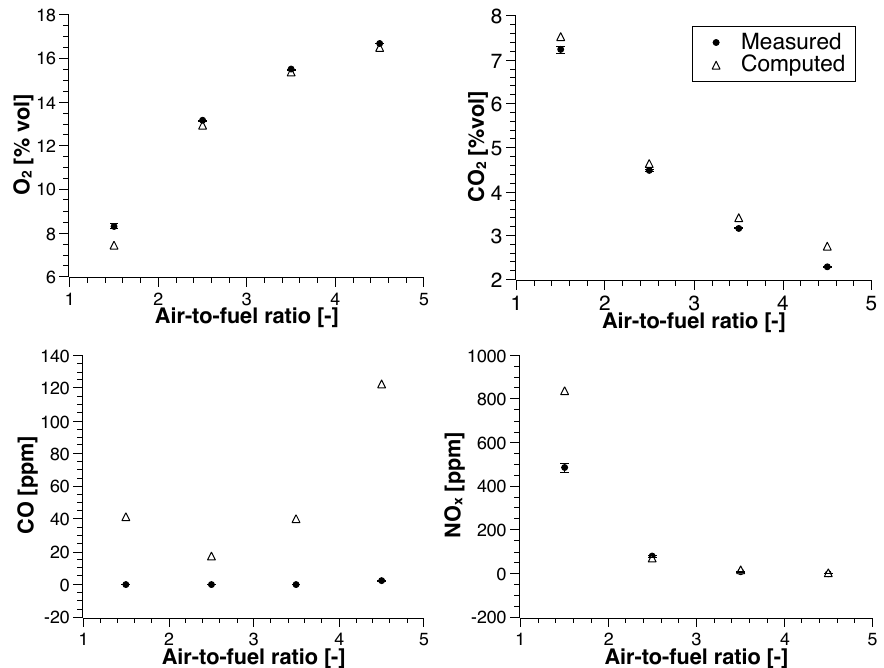
Figure 15. Comparison between measured and computed values of O 2 (% vol), CO 2 (% vol), CO (ppm), and NO x (ppm) concentrations in the exhaust gas for different values of the air-to-fuel ratio. Air inlet temperature 730 ◦ C. GRI3.0 kinetic